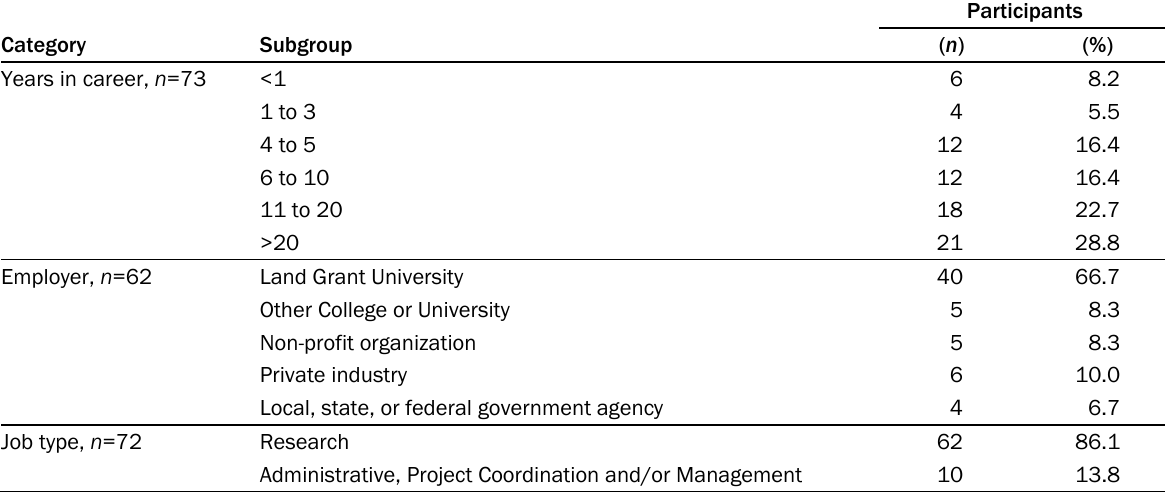
Table 1. Characteristics of Survey Participants: Career Stage and Employer